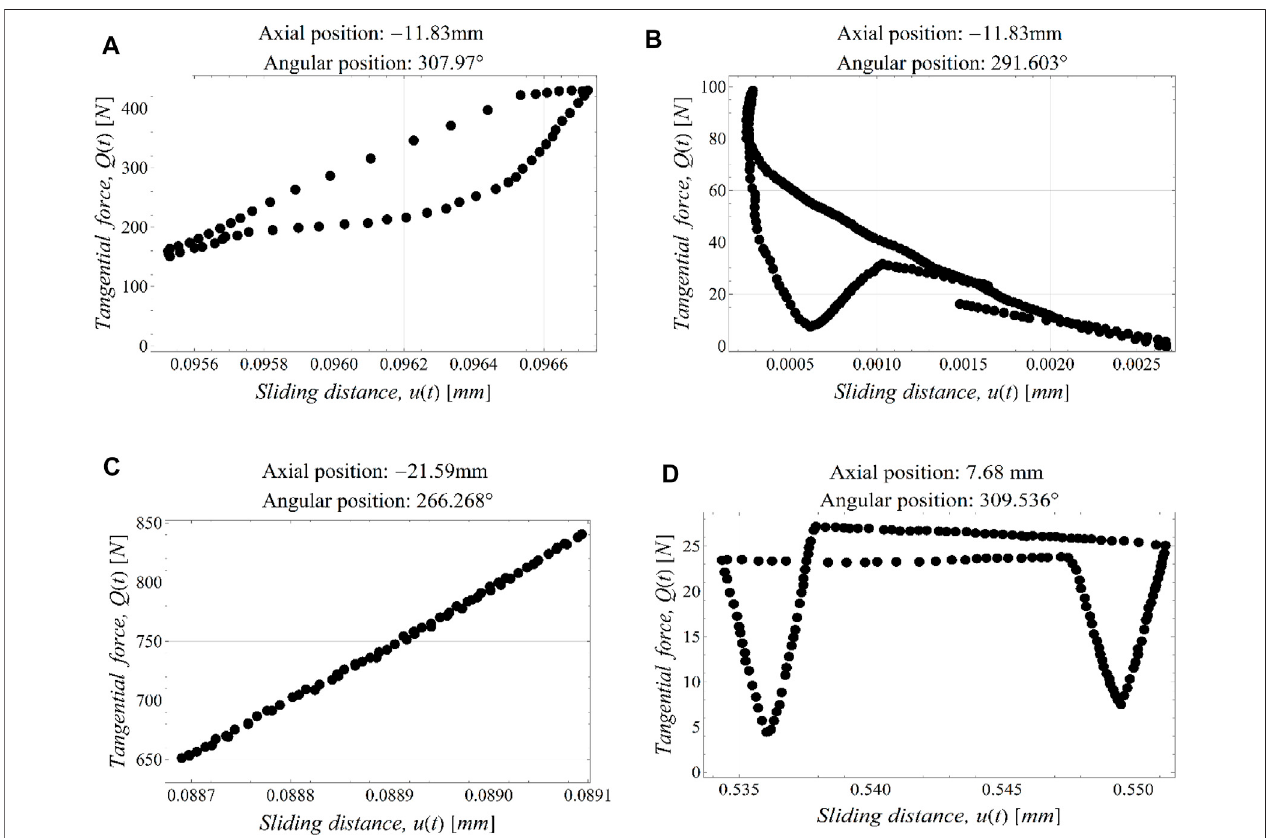
FIGURE6| ExamplesoffrettingregimesindicatedbytheplotofQ(t)againstu(t)whentheconductorgoesthrough β 0 ± Δ β forabendingamplitudeof0.75 mm. (A) Mixedfrettingregimeonalayer4tolayer3contact. (B) Mixedfrettingregimeonalayer4toclampcontact. (C) Stickingcontactonalayer4tolayer3contact. (D) Gross slip contact on a layer 4 to